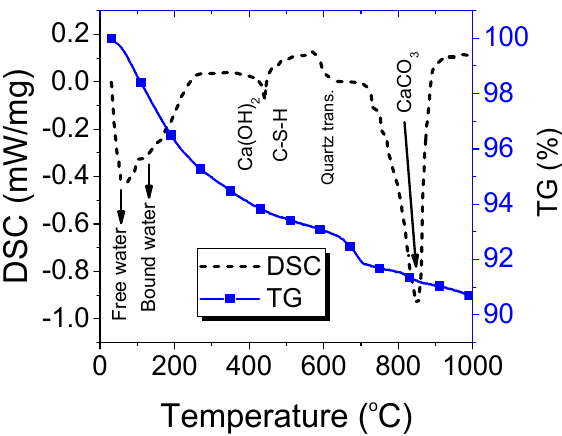
Figure 13. Thermogravimetric (TG) and differential scanning calorimetry (DSC) curves for RPC at different temperatures.